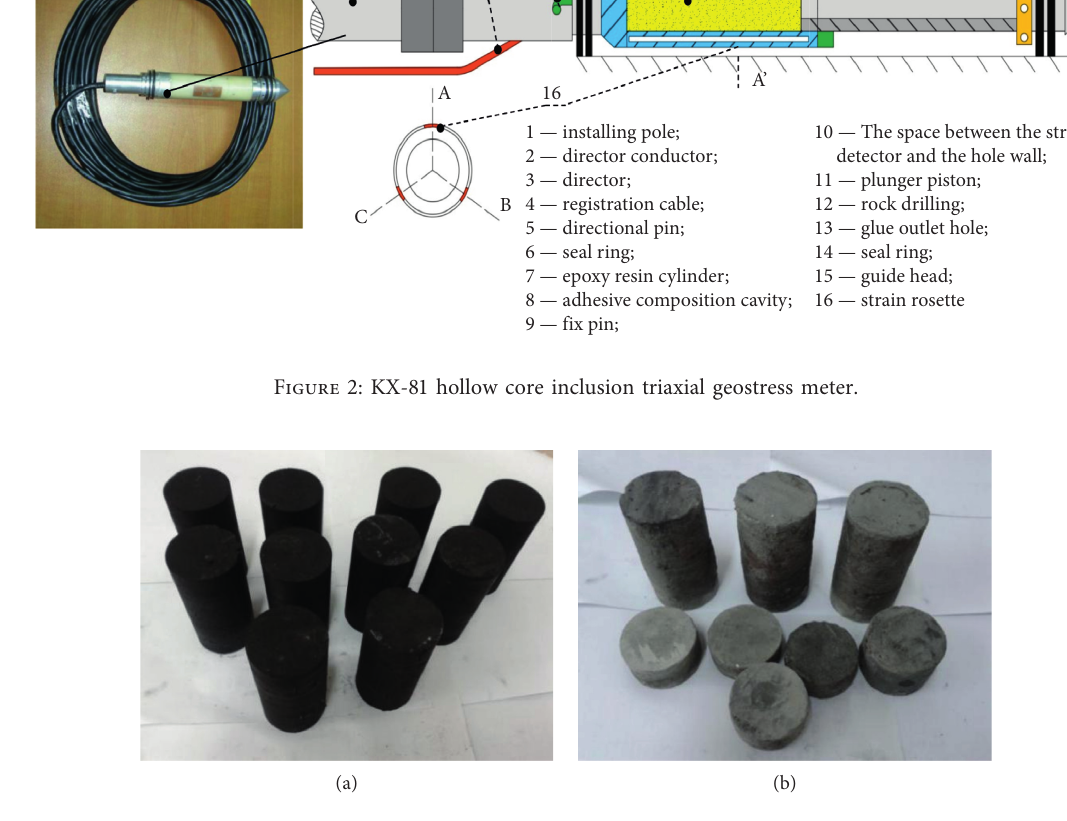
Figure 3: Some standard testing samples. (a) Coal samples. (b) Rock samples.